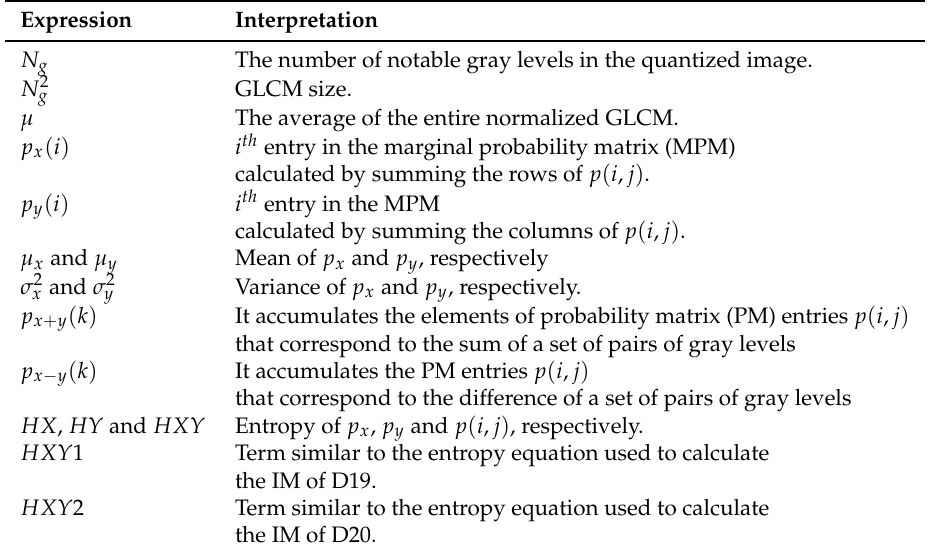
Table 2. Interpretations for terms used to compute descriptors from the